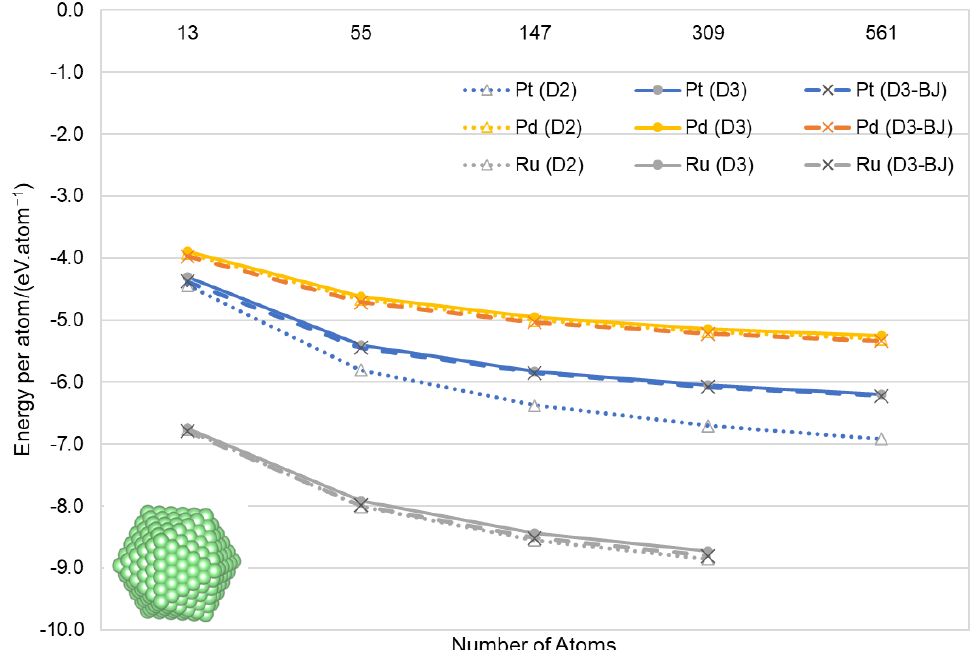
Figure 3. Energy per atom as a function of size for icosahedral Ru, Pd and Pt nanoparticles calculated with the three modelling methods, DFT-D2, DFT-D3 and DFT-D3(BJ). of 12/1), compared to the next size ratio of 3.23 for G m = 55 (42 surface atoms to 13